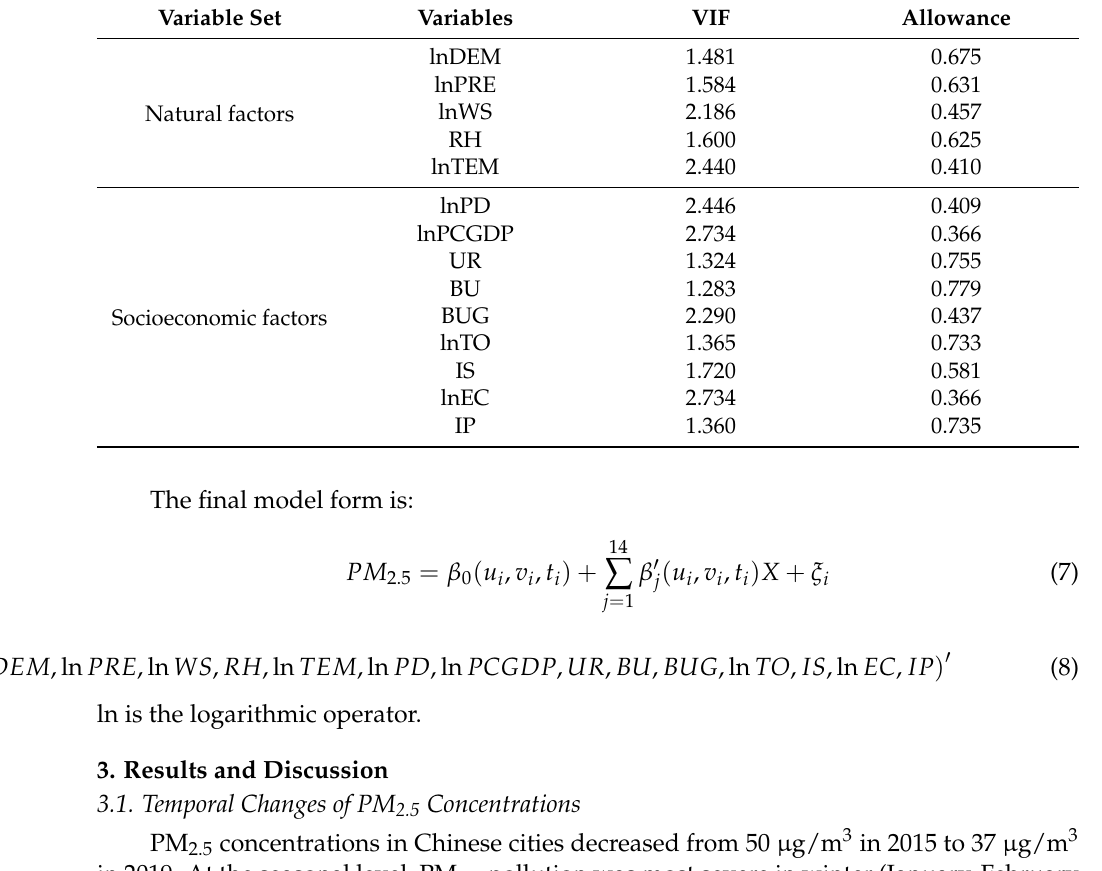
Table 2. Multicollinearity test of